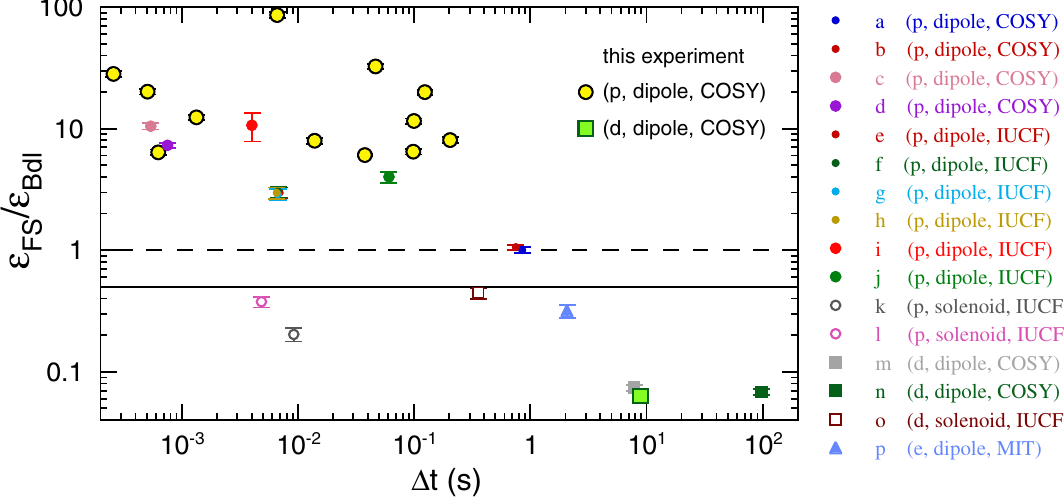
FIG. 7. (Color) Ratio of E to E is plotted vs the ramp time (cid:1) t giving P (cid:1) 0 in each (cid:1) t curve [31]. E FS Bdl is obtained using each data point’s R Bdl in Eq. (4) or (5). The dashed and obtained by fitting the data in each (cid:1) t curve to Eq. (3); E Bdl solid lines show the ratios predicted by [26–28] and [29,30], respectively. Note that points (a) and (b) overlap, as do points (e)–(h). The data for all points are listed in Table I.